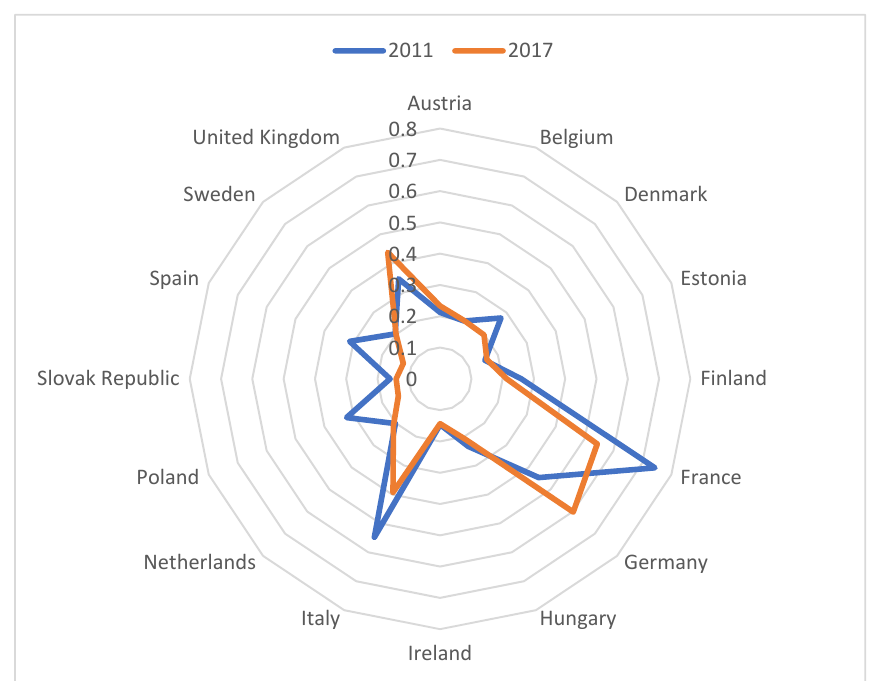
Energies 2021 , 14 , x FOR PEER REVIEW Figure 2. The average level of the SMI for selected EU countries in 2011 and 2017.